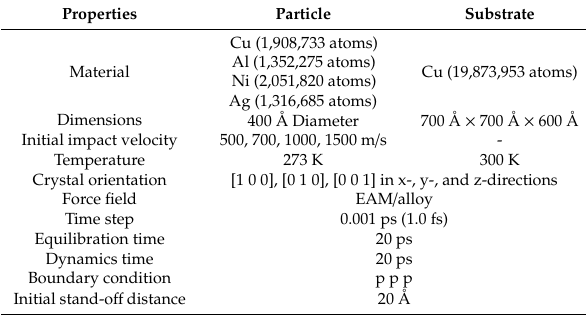
Table 1. Schematic molecular dynamics simulation calculation